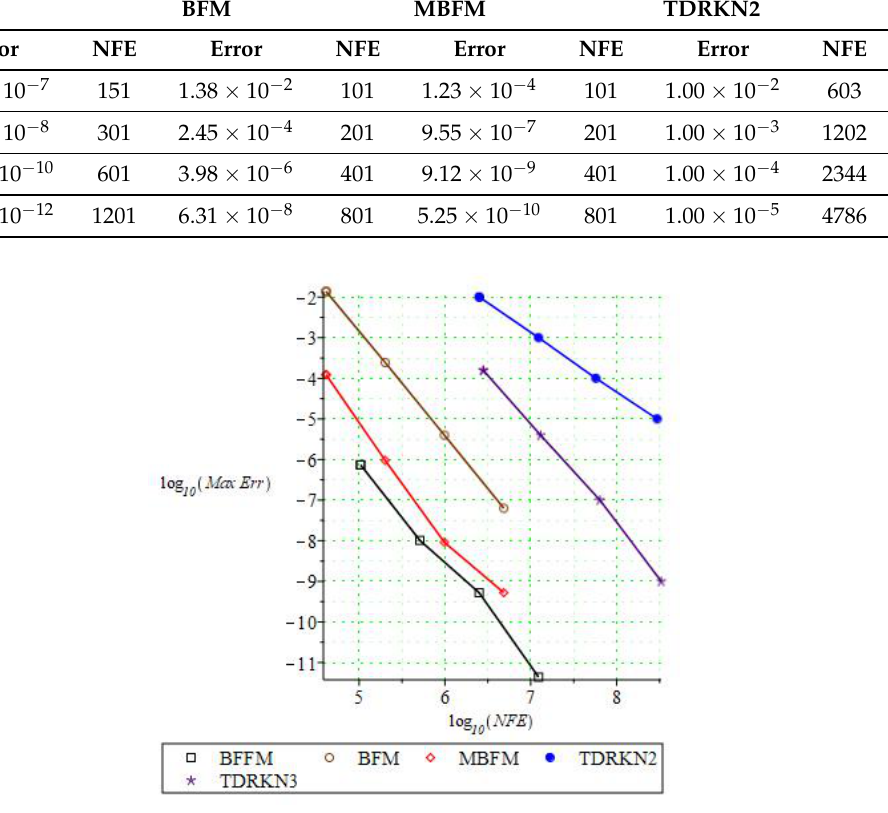
Figure 5. Efficiency Curves for Example 3.